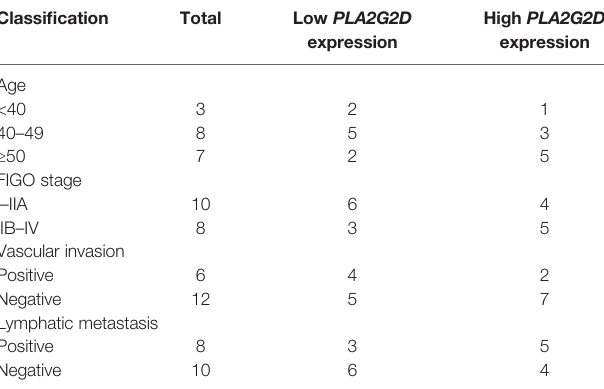
FIGURE 5 | Further validation of the relationship between PLA2G2D expression and immune in fi ltration. (A) Heatmap for PLA2G2D high- and low-expression groups based on the MCP-counter, ESTIMATE, EPIC, and quanTIseq algorithms using data from the CGCI database. (B) Violin plot showing the differential scores of six immune cell types determined by the MCP-counter algorithm. (C) Violin plot showing the differential StromalScore, ImmuneScore, and ESTIMATEScore determined by the ESTIMATE algorithm. (D) Violin plot showing the differential immune cell types determined by quanTIseq and EPIC algorithms. (E, F) Histograms showing the relationship between the expression levels of PLA2G2D and WGCNA fi ltered fi ve co-expressed genes using data from the CGCI database (D) and freshly isolated clinical samples (E) . * P < 0.05, ** P < 0.01, *** P < 0.001, and **** P < 0.0001. TABLE 3 | Clinical characteristics of patients from our CSCC cohort. Classi fi